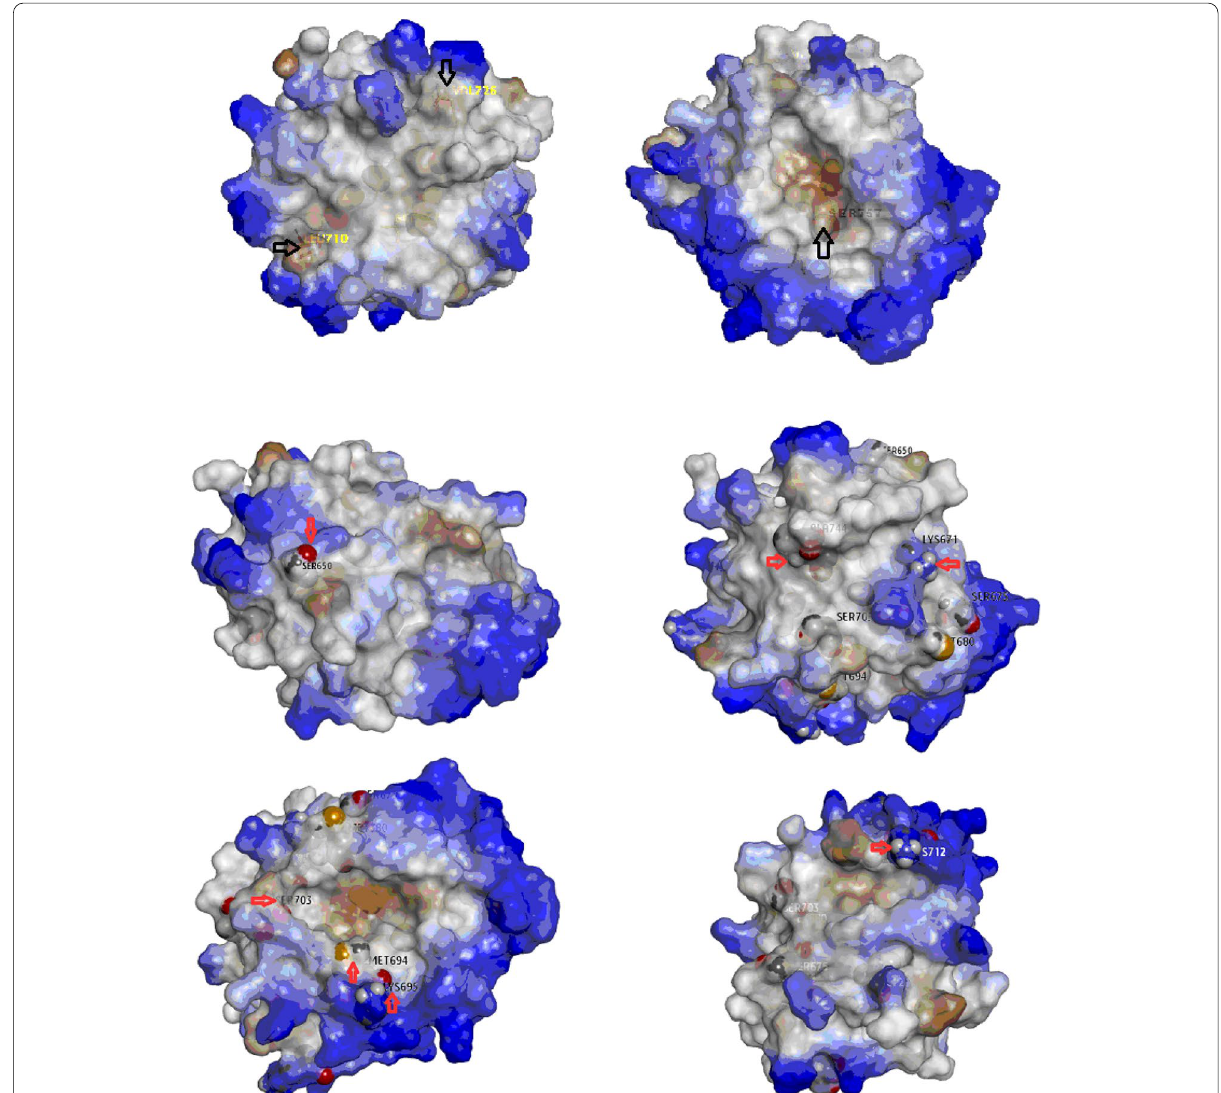
Fig. 3 Localization of the 13 retrieved B30.2 domain variants on the hydrophobicity mapping, the arrows point to each variant